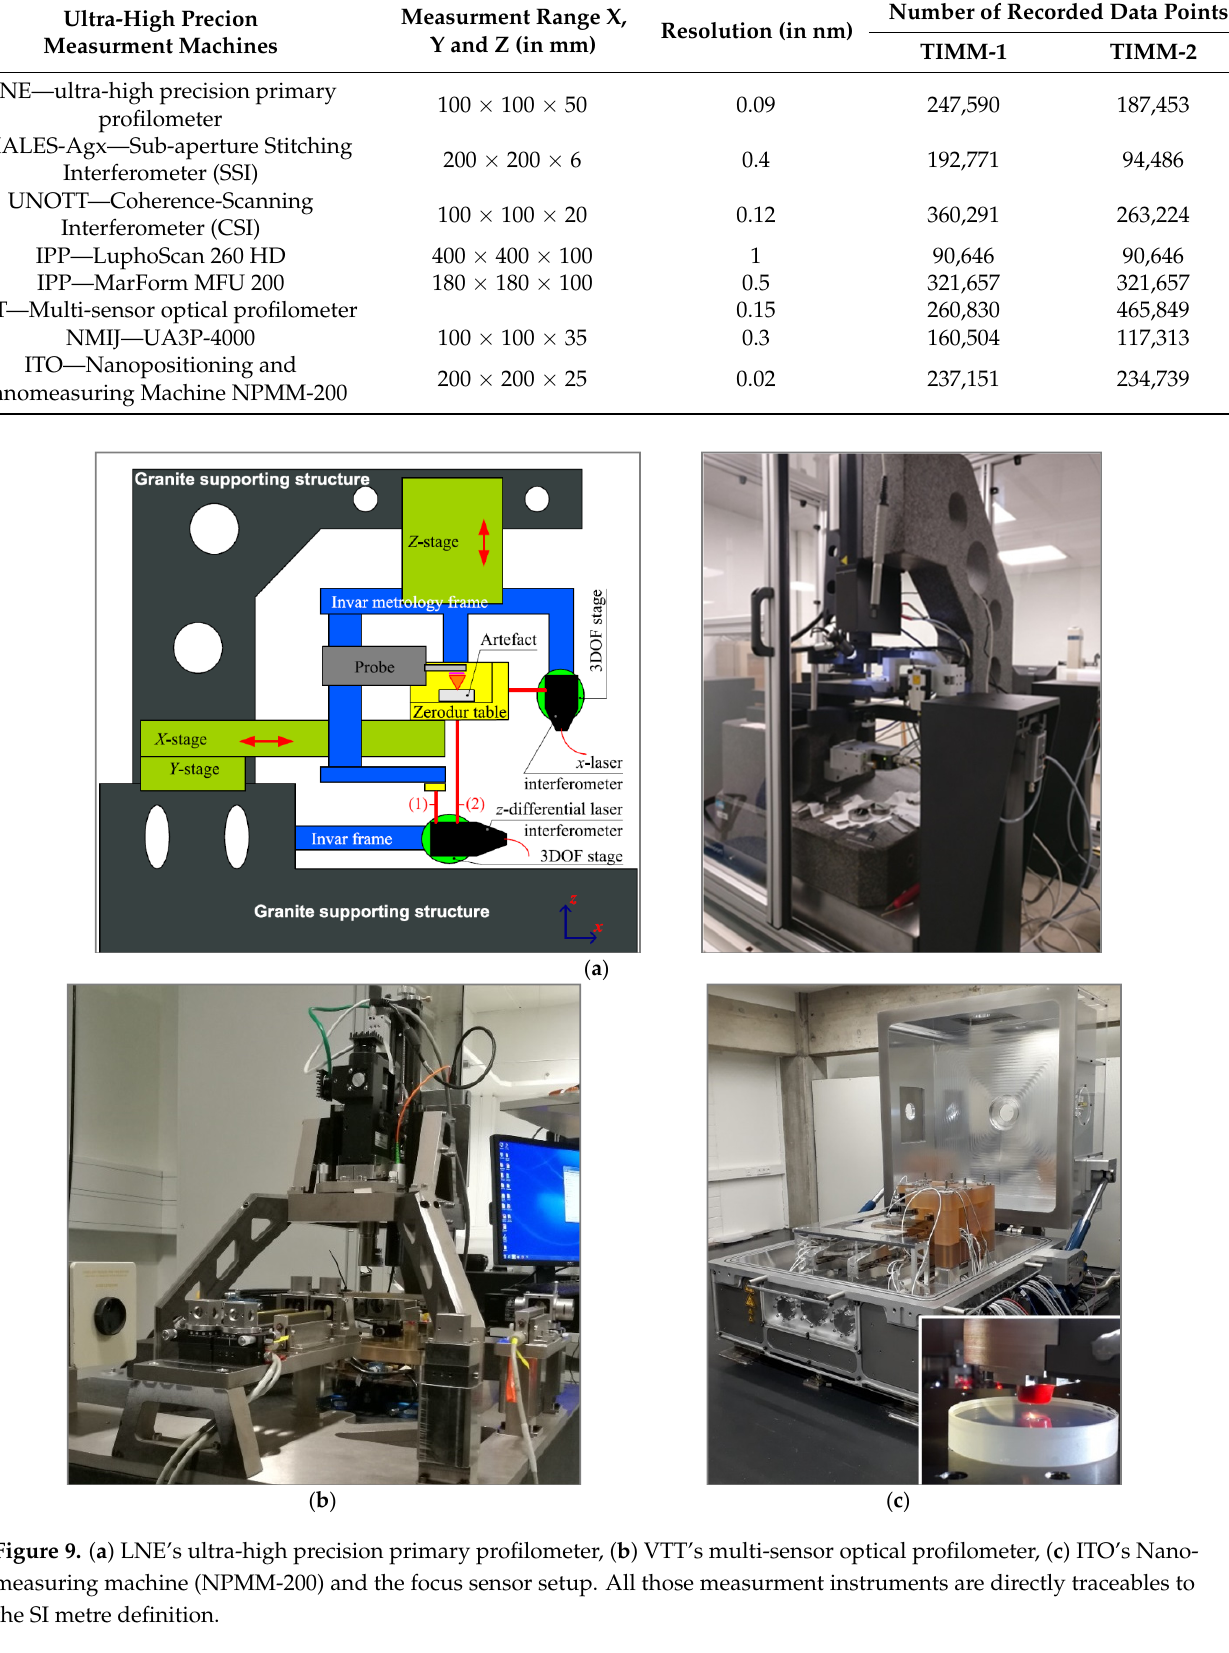
Table 4. Description of the measurement range and resolution of the selected ultra-high precision measurement systems, and number of collected data points.